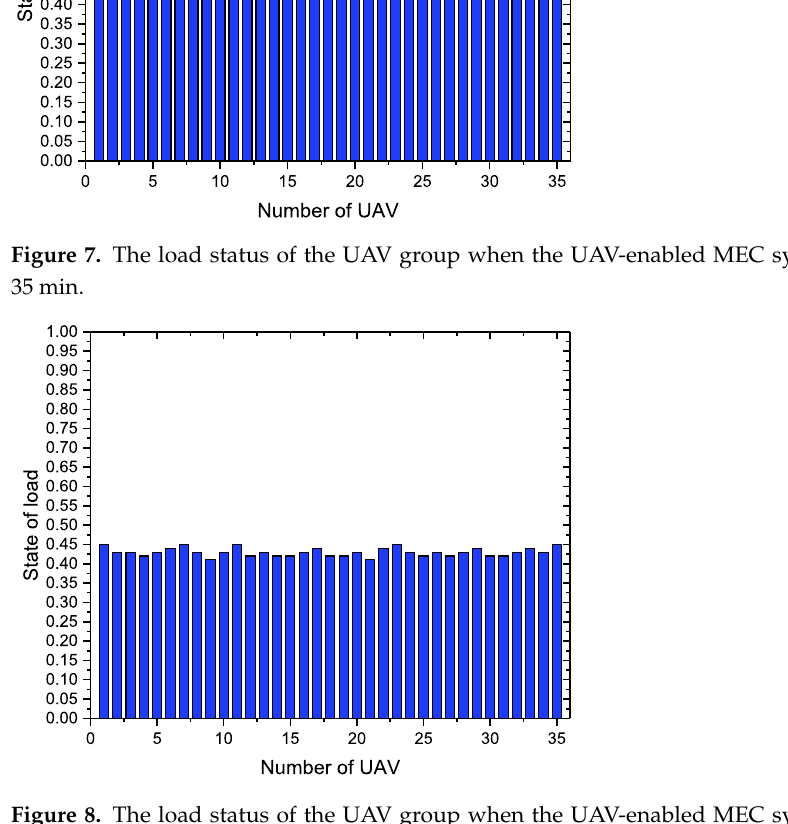
Figure 8. The load status of the UAV group when the UAV-enabled MEC system is running for 65